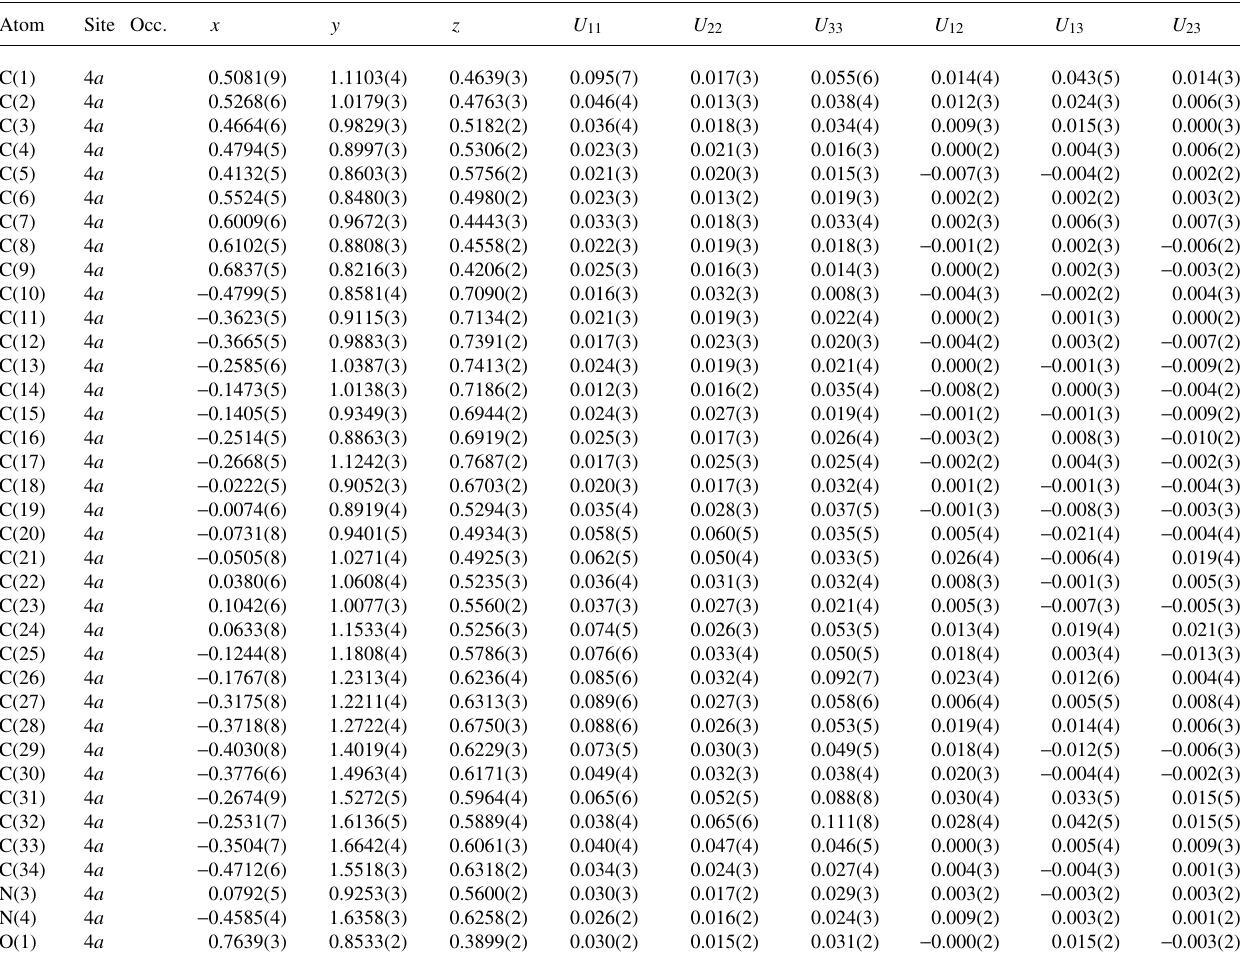
Table 3. Atomic coordinates and displacement parameters (in Å 2 ) .